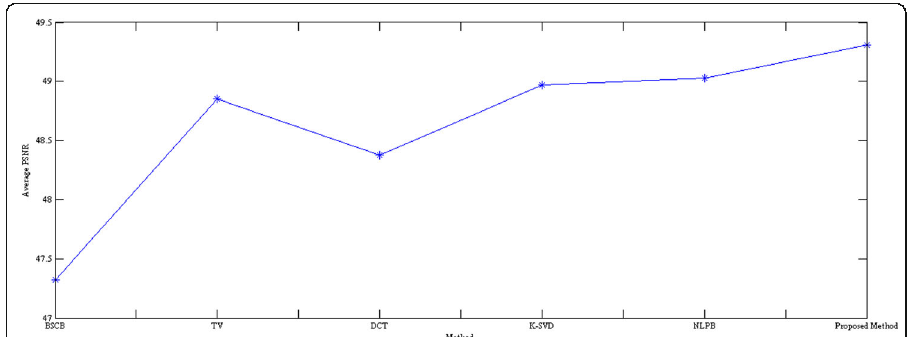
Fig. 8 Average PSNR of each